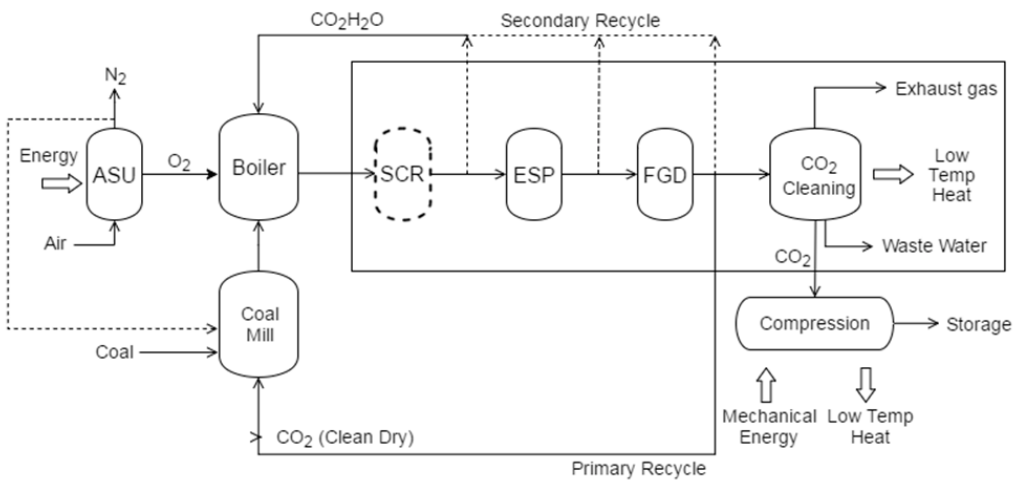
Figure 2. The configuration of a coal-fired power plant [12].